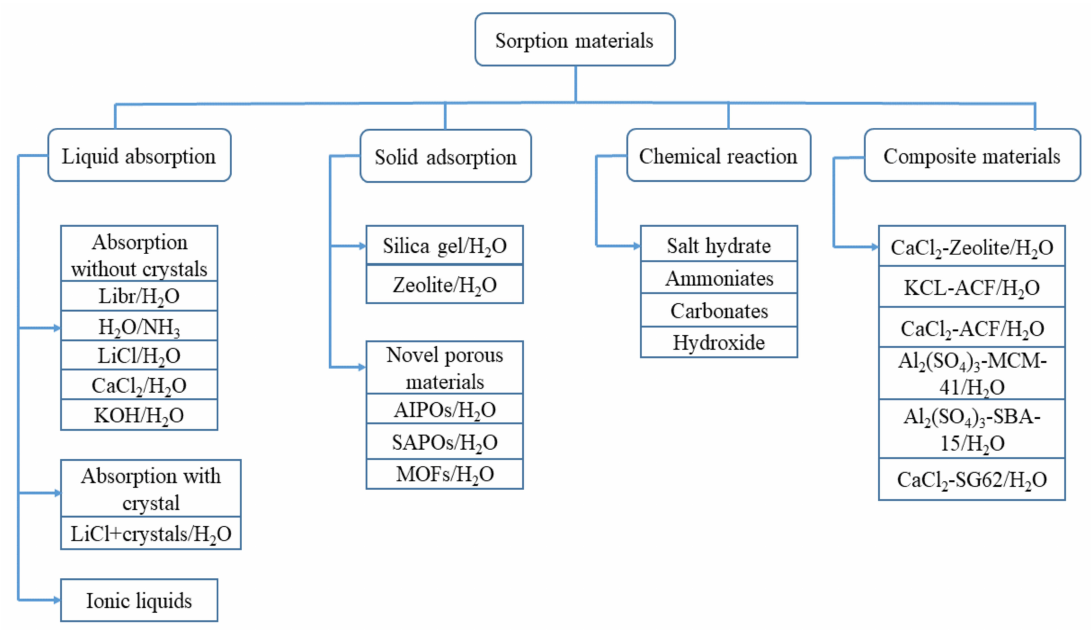
Figure 4. Categorization of sorption materials